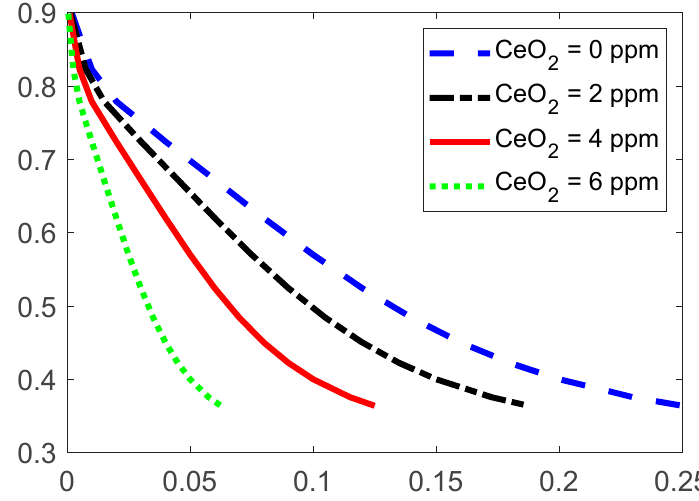
Figure 2. The obtained experimental I-V characteristic curve of the contaminated and non-contaminated PEMFC. Noted that CeO 2 = 6 ppm was not measured in this study, and it is an estimation from the contamination by CeO 2 = 2 ppm and CeO 2 = 4 ppm.